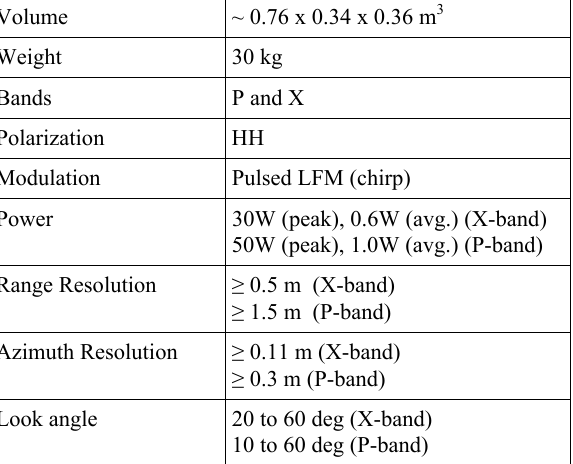
Table 2: SAR main characteristics